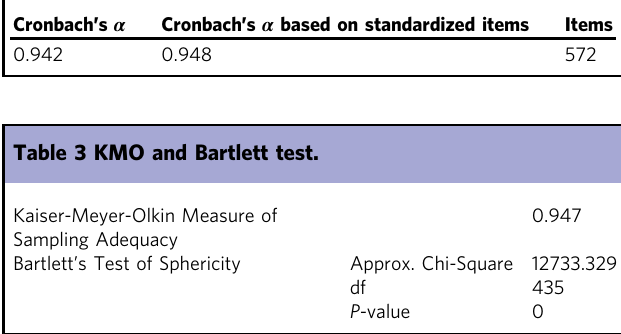
Table 2 Reliability statistics.